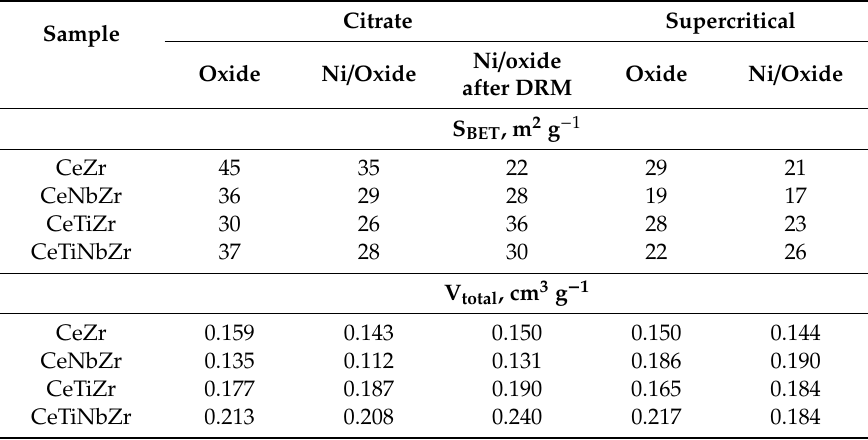
Table 2. Textural properties of samples. Calcination temperature 700 °C.